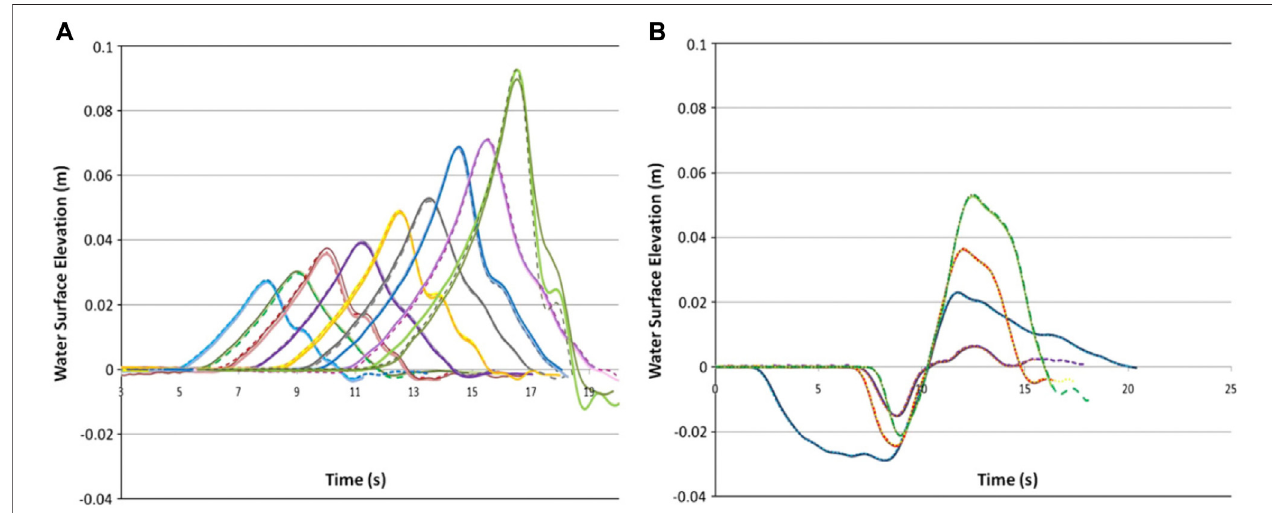
FIGURE2| RepeatabilityofelevatedandN-waveswiththe fi rstgenerationTS(Rossettoetal.,2011),thepro fi lesobtainedfromthreetestsforeachofninedifferent solitary wave heights (A) and (B) the pro fi les obtained for three tests for four different N-waves. Different line styles represent different repeat tests (solid, opaque and